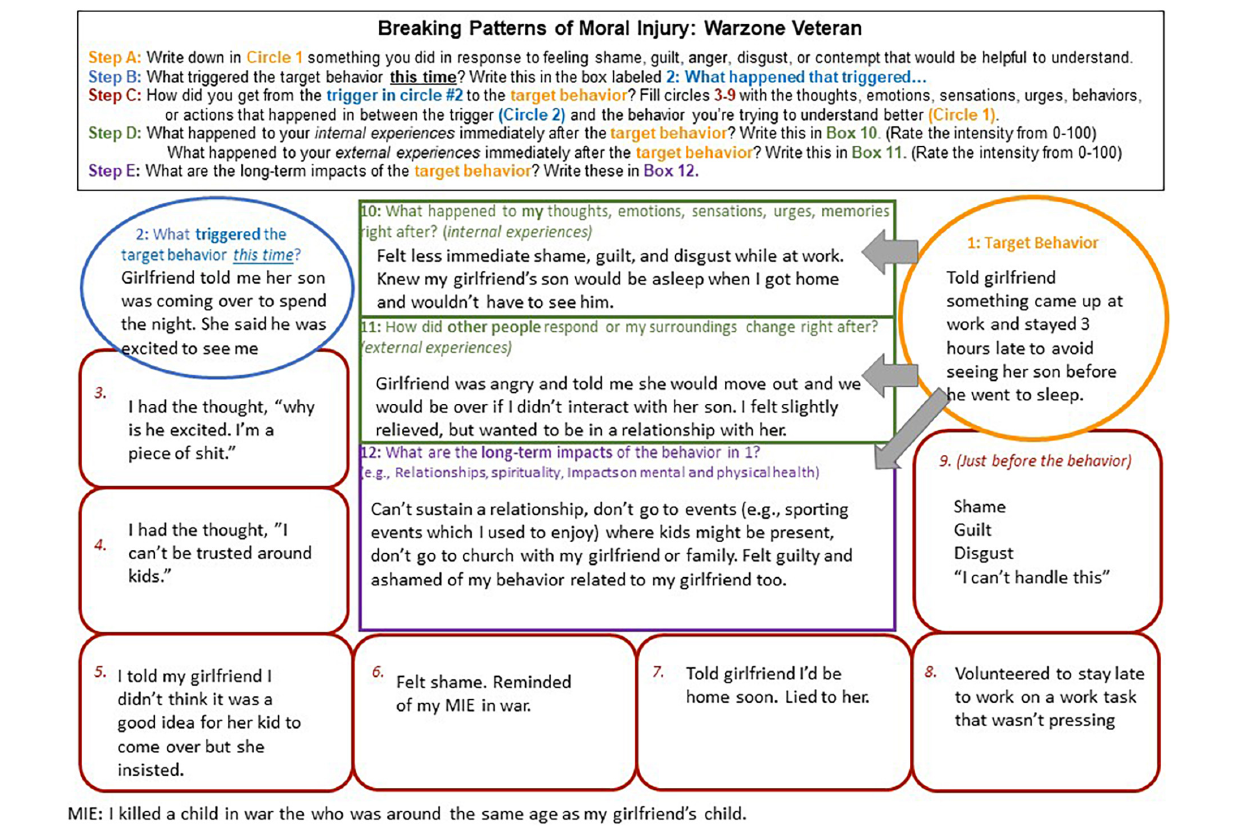
FIGURE 2 | A warzone Veteran case example of a chain analysis demonstrating the factors maintaining moral